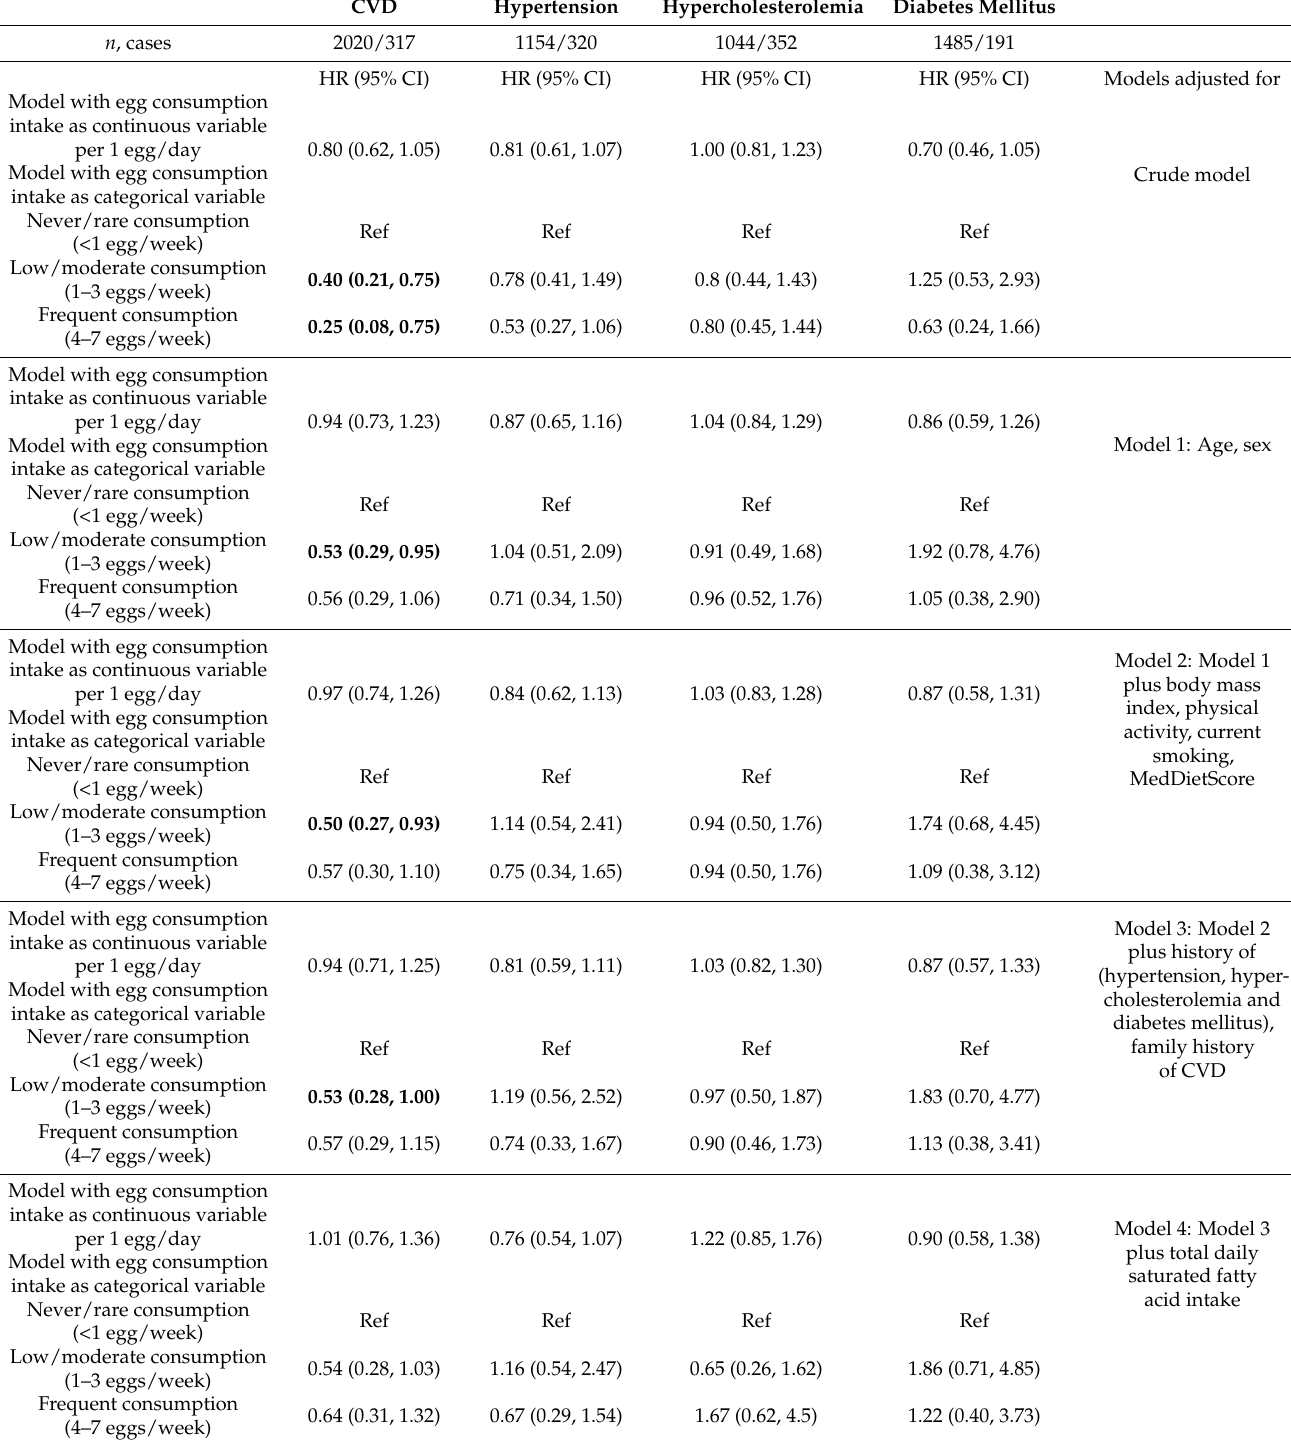
Table 3. Sensitivity analyses to evaluate the association of egg consumption intake (portions/week) with 10-year cardiometabolic endpoints of cardiovascular disease, hypertension, hypercholes- terolemia, diabetes mellitus ( n =